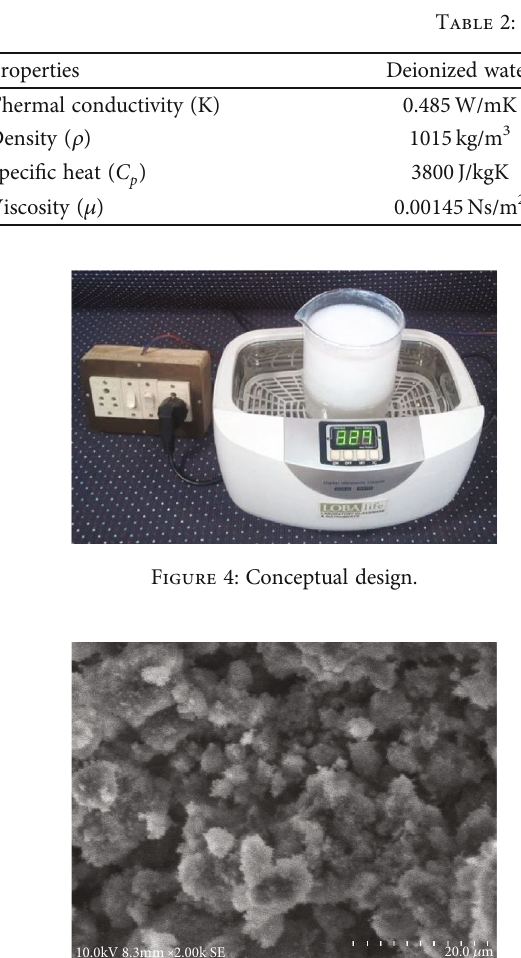
Figure 5: Part of microchannel check-schematic view.